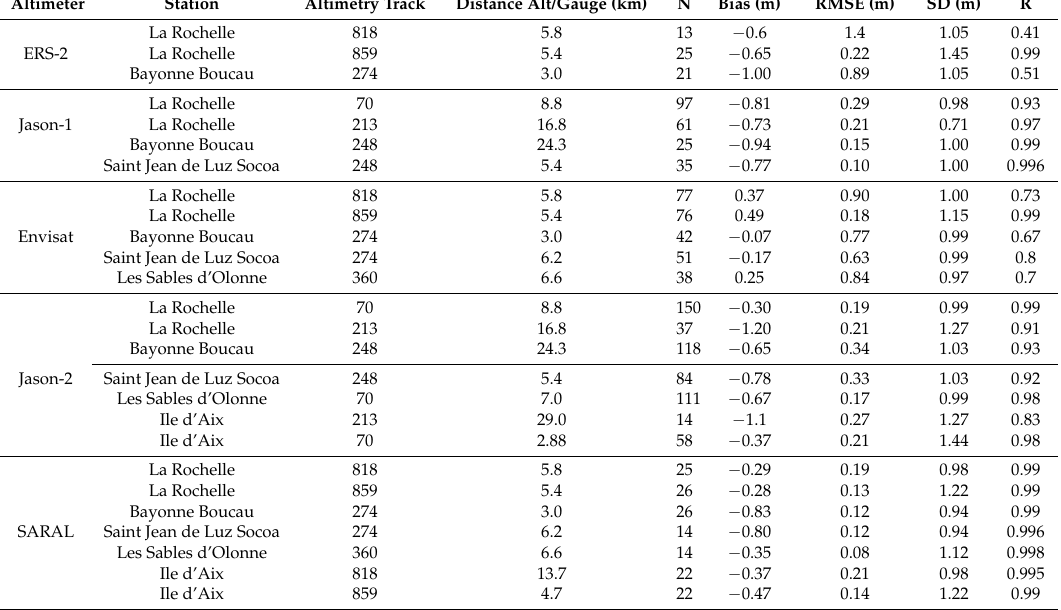
Table 3. Comparisons of distance to the gauge, number of cycle observations (N), bias, root mean square error (RMSE), SD, and the correlation coefficient (R) from zero to five kilometers away from the coast for all tide gauge stations present along the French Atlantic coast of the southern part of the Bay of Biscay for ERS-2, Jason-1, Envisat, Jason-2, and SARAL. The ionosphere and wet troposphere corrections were derived from the Global Ionospheric Maps (GIM) and European Center for Medium Range Weather Forecasting (ECMWF) models,